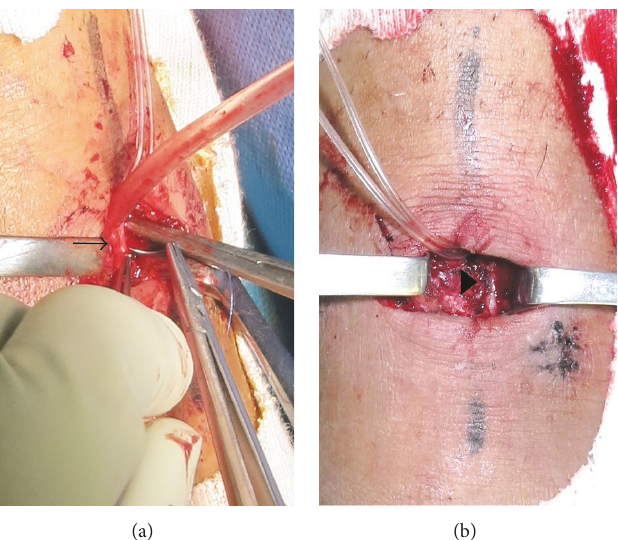
Figure 8: Photographic images taken during repair of the anterior tibial artery injury demonstrated that the pseudoaneurysm was caused by disruption of the posterior third of the anterior tibial artery wall (arrow) on the anterior side of the ankle joint (a). The injured anterior tibial artery wall was repaired using an end-to-end anastomosis longitudinally (arrow head), without compromising the blood supply to the foot